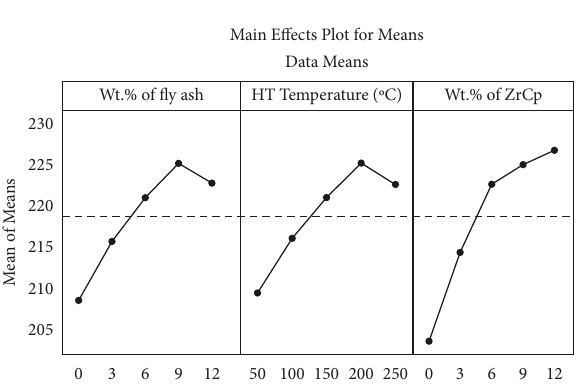
Figure 6: Main-effect plot for UTS (mean).